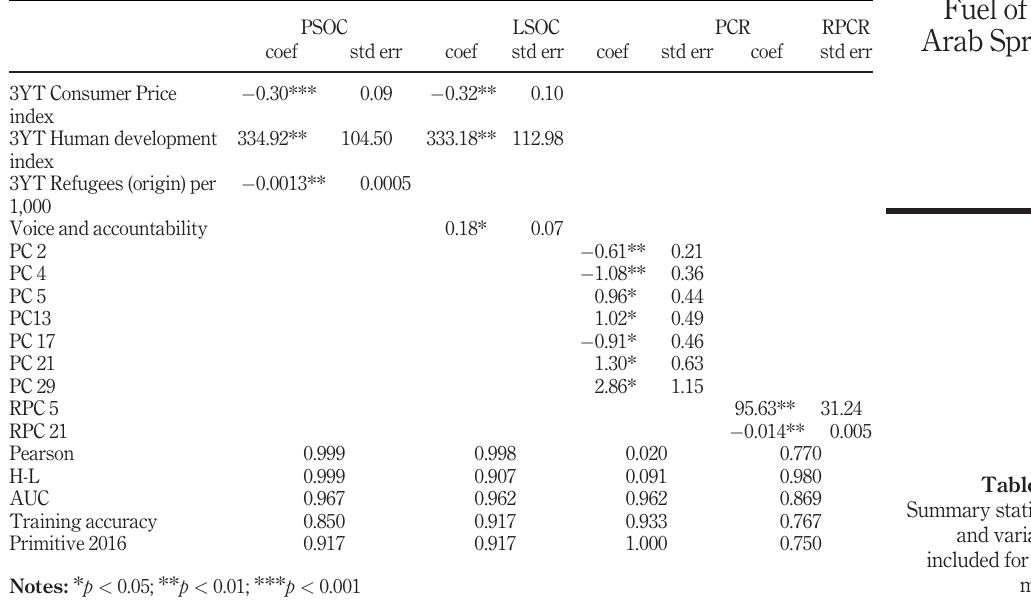
Table III. Summary